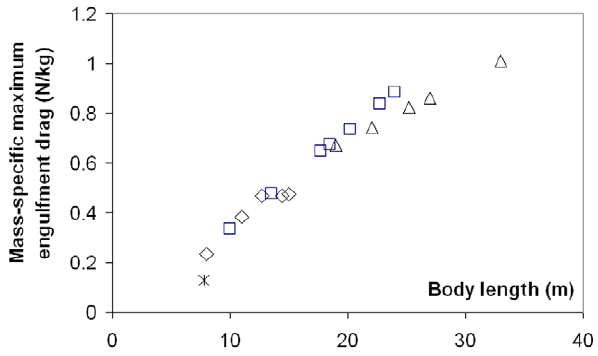
Figure 6. Maximum engulfment drag (mass-specific). Largest value attained during mouth opening, by humpback (diamonds), fin (squares), blue (triangles) and minke whales (starburst).